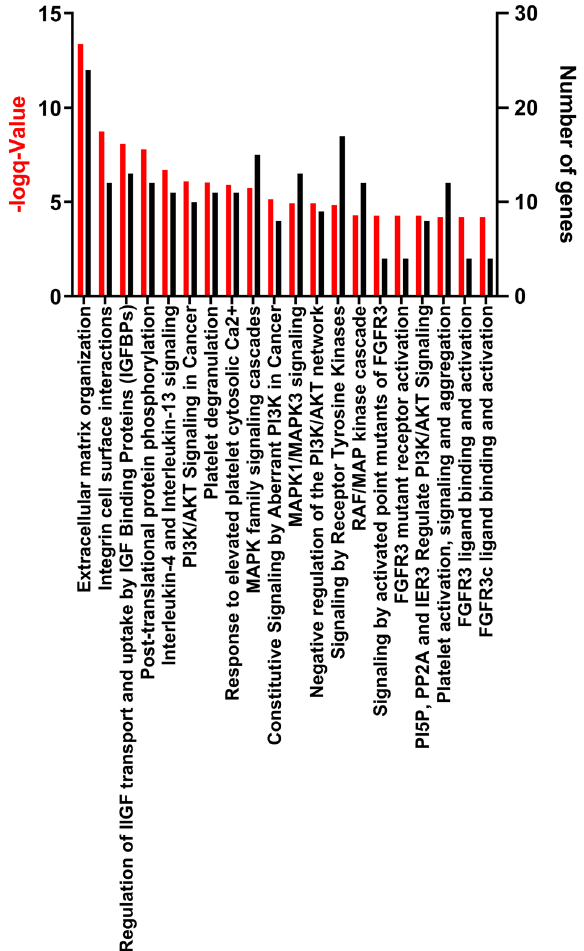
Figure 5. Reactome Top 20 (up) regulated pathways using pathway names and number of genes with fold- change > 2 and adjusted p -value < 0.01 for EXT-PNI versus